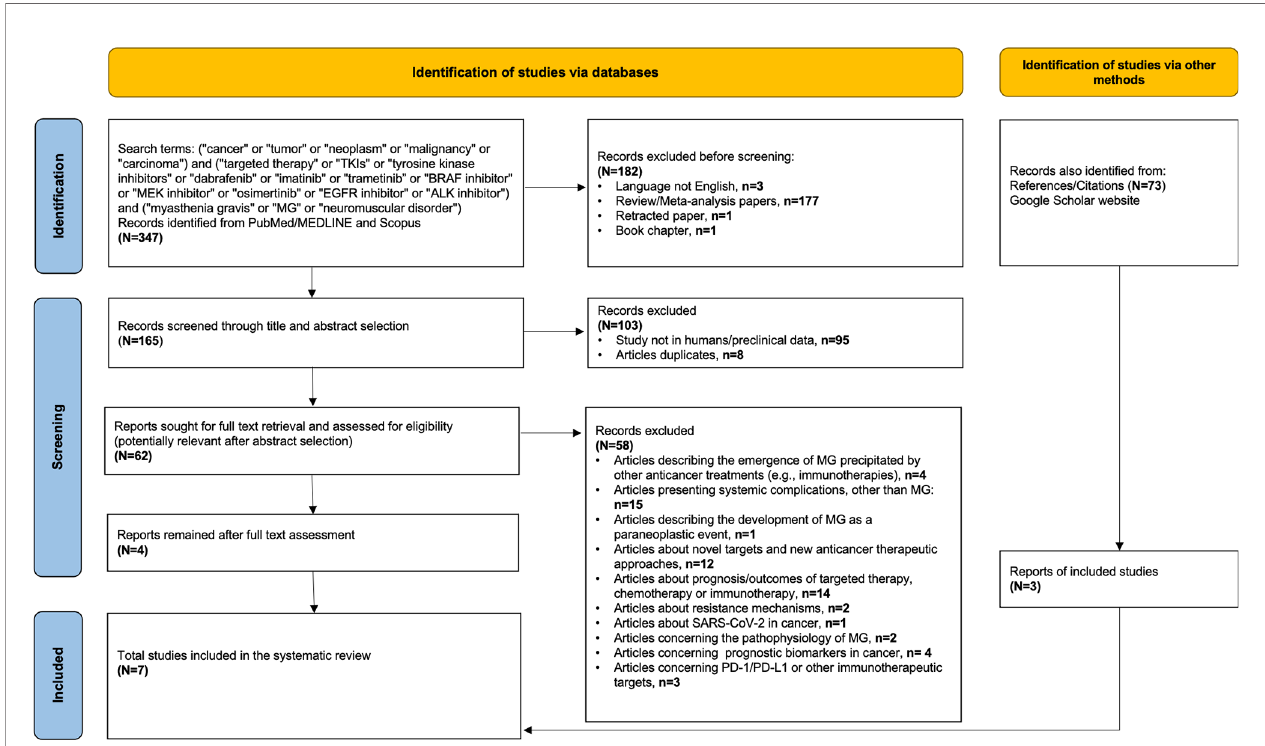
FIGURE 2 | Flow diagram of literature search strategy, according to the PreferredReporting Itemsfor SystematicReviews and Meta-analysis(PRISMA) 2020